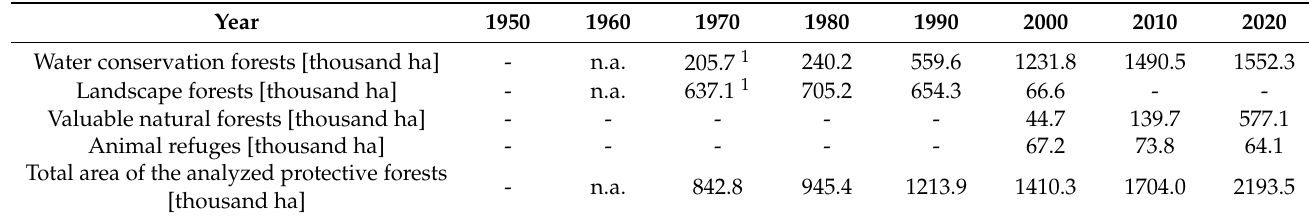
Table 5. The area of selected categories of protective forests in SF